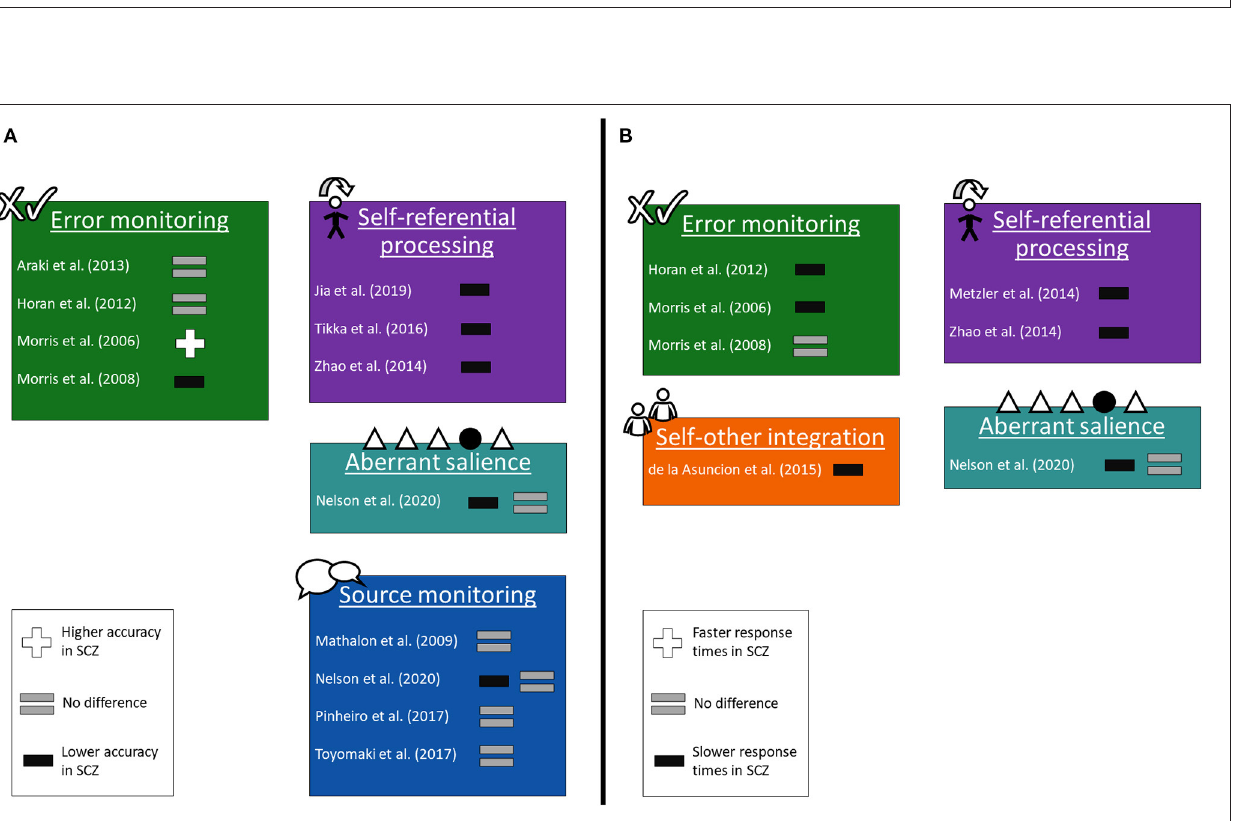
FIGURE 2 | Changes in behavioral responses. The studies grouped into the same paradigms as in Figure 1 , showing the differences between subjects with schizophrenia and healthy controls in task responses. (A) Differences in accuracy. (B) Differences in response times.